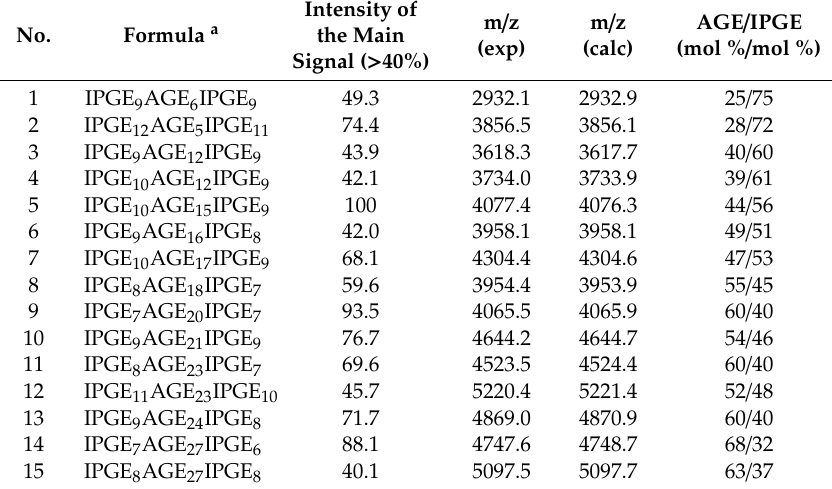
Table 5. Composition of PIPGE / PAGE / PIPGE triblock copolyether-diol (19) determined by MALDI-TOF mass spectrometry.